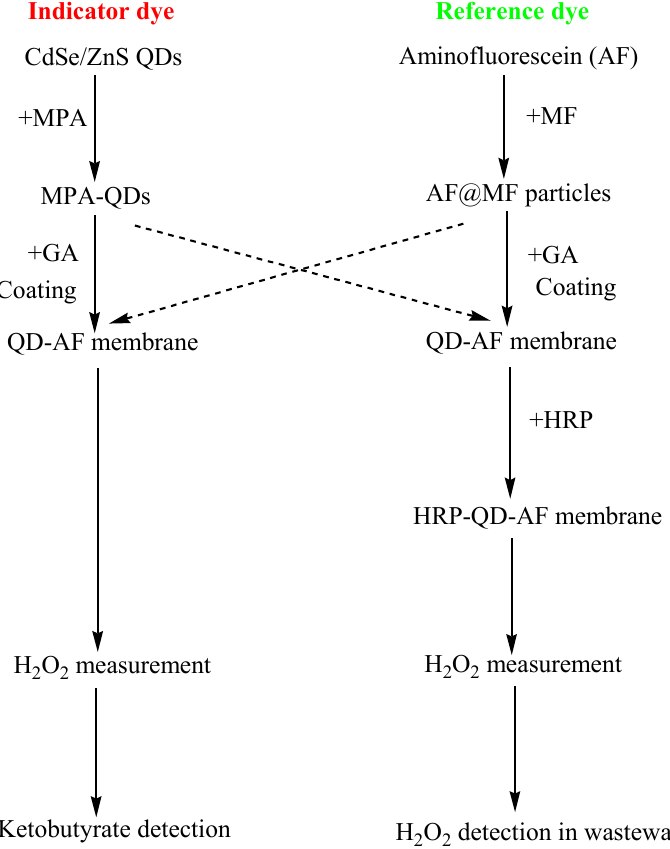
Scheme 1. Fabrication of the quantum dot / aminofluorescein (QD–AF) membrane and the horseradish peroxidase (HRP) QD–AF membrane and their colorimetric and ratiometric fluorescent response to di ff erent H 2 O 2